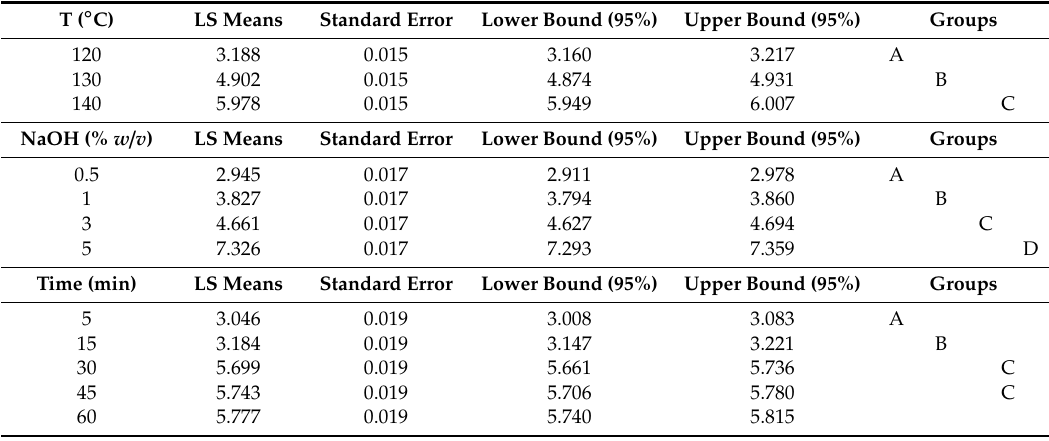
Table A2. Tukey’s HSD test results for the MW-A pretreatment in water medium in relation to the saccharinic acids yield (g / L). Analysis of the di ff erences between the categories with a confidence interval of 95% for: Temperature (top), NaOH concentration (center) and time